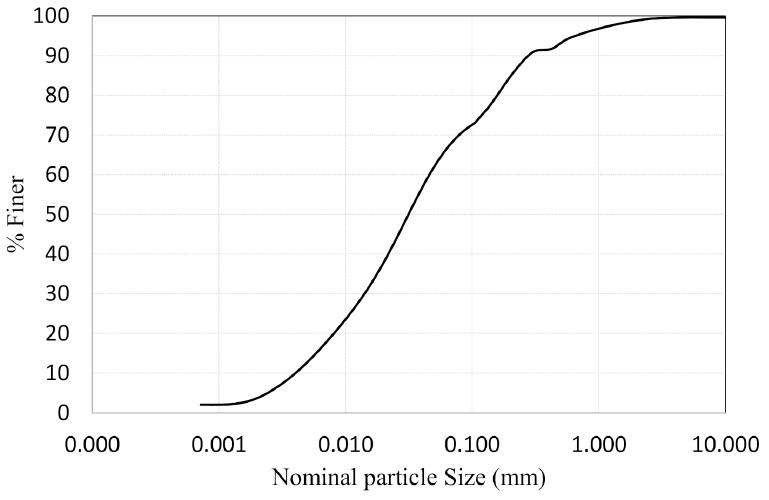
Figure 3. Particle size